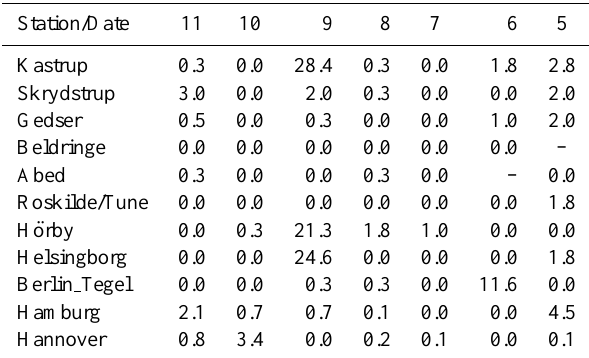
Table A2b. Daily measured precipitation in mmday − 1 in the poten- tial source region to the episodes of Alternaria spore concentrations (sporesm − 3 ) that were measured 10–11 August 2010. The last 7 days of recorded precipitation until the potential episode is used as an indicator of good harvesting possibilities. “–” usually means no precipitation was recorded, but could potentially also mean techni- cal problems.